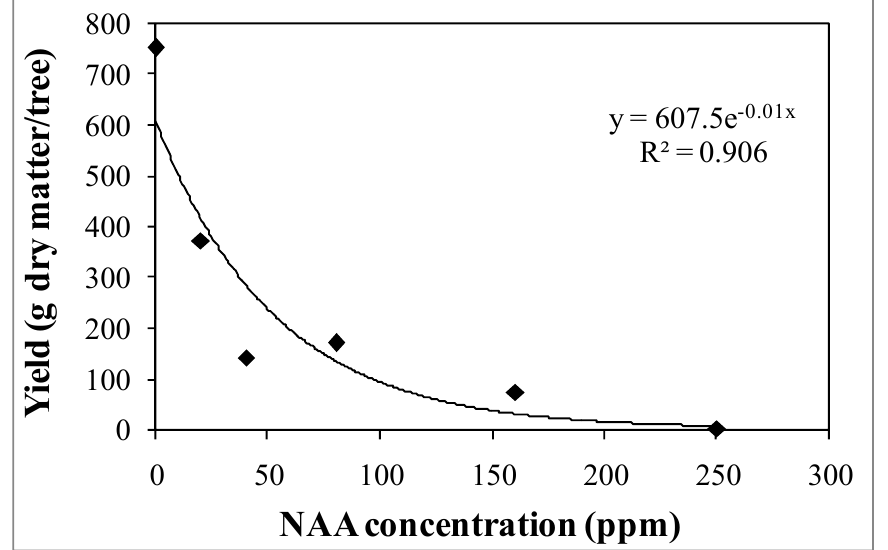
Figure 3. Relationship between NAA concentrations and the yield per tree at the end of the vegetative season (2019) in a young intensive olive orchard of the cultivar Moraiolo. Values are means of 4 replicates per treatment.